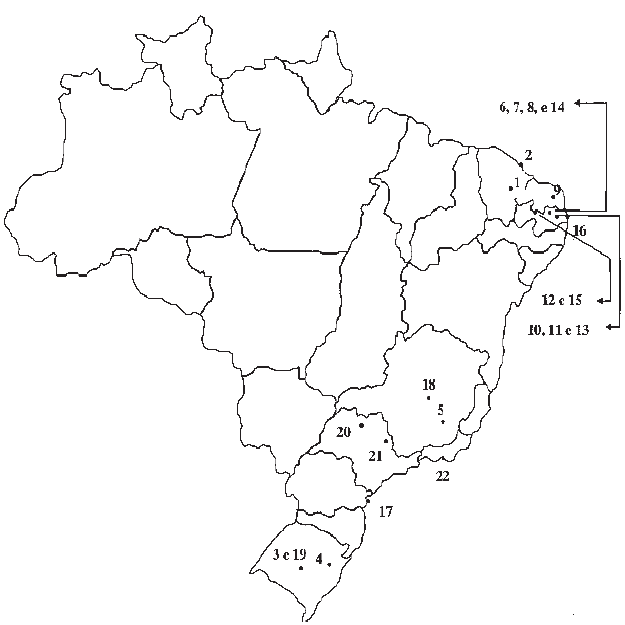
Figura 1. Distribuição dos solos estudados no território